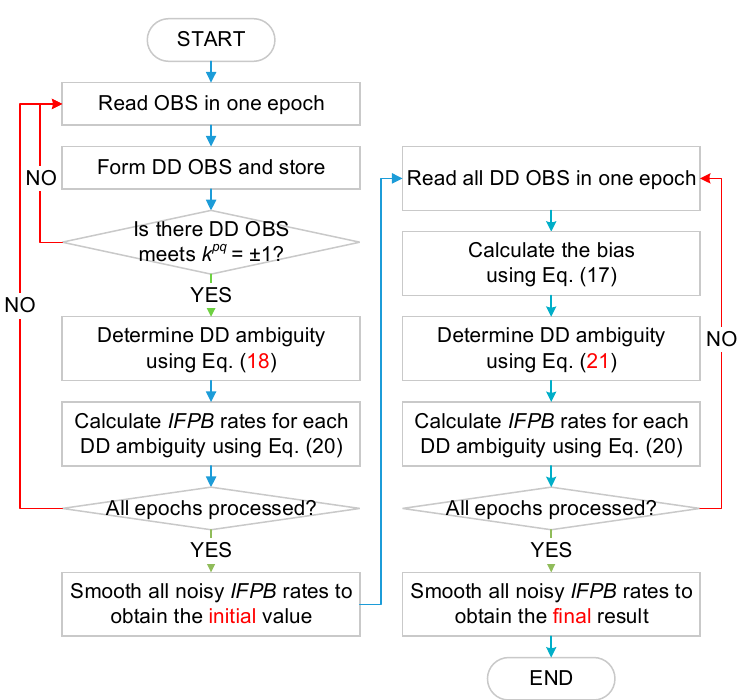
Figure 1. Flowchart of the IFPB rate estimation. DD: double-differenced, IFPB : inter-frequency phase bias, OBS: observations.